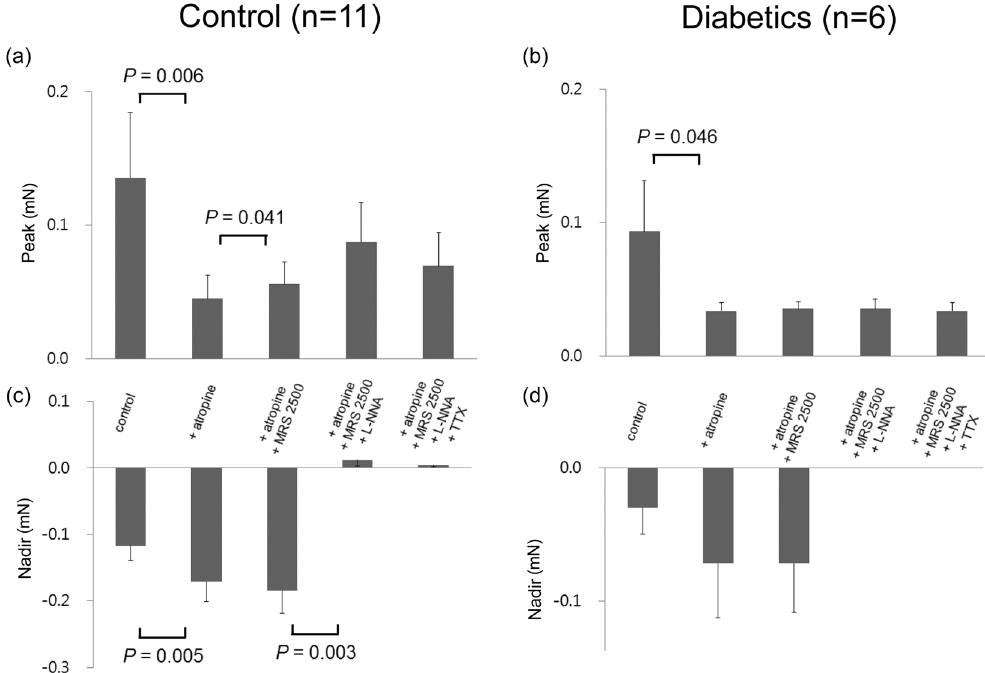
Figure 2. Electrical field stimulation (EFS)-induced response of proximal gastric circular muscle strips after serial administration of atropine, MRS2500, N-nitro-L-arginine (L-NNA), and tetrodotoxin (TTX). ( a ) Atropine decreased the peak and MRS2500 increased the peak in the control subjects. ( b ) Atropine decreased the peak in diabetic patients. ( c ) Atropine increased the nadir and L-NNA abolished relaxation in the control subjects. ( d ) Also in the diabetic patients, L-NNA decreased the nadir with marginal statistical significance (p = 0.080). The Wilcoxon signed-rank test was used to evaluate the effects of each drug by compare values to the previous